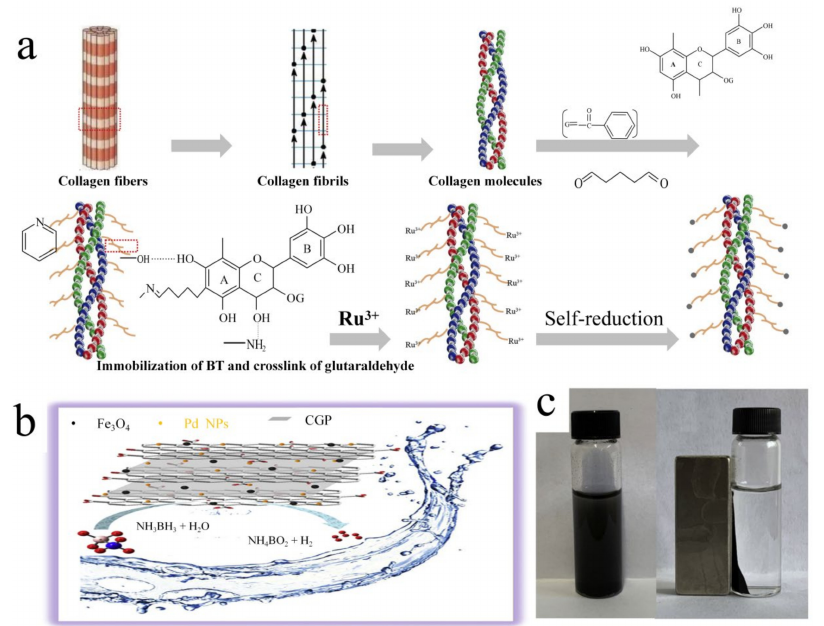
Figure 3. ( a ) Schematic diagram of CF-BT-Ru synthesis. Reprinted from Ref. [91] Copyright (2021) with permission from Elsevier. ( b ) Schematic diagram of Pd/CGP-GO-Fe 3 O 4 catalyzing hydrogen production from ammonia borane, ( c ) recovery of Pd/CGP-GO-Fe 3 O 4 . Reprinted from Ref. [95]. Copyright (2019) with permission from